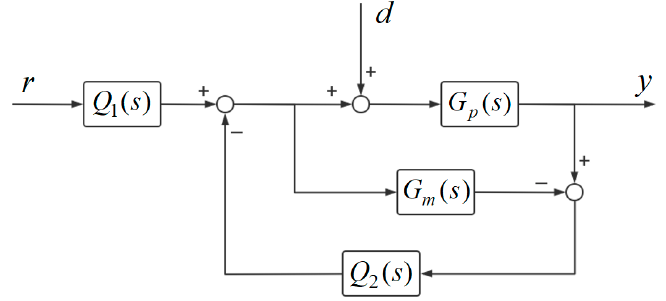
Figure 1. The 2DOF control structure with IMC controller.